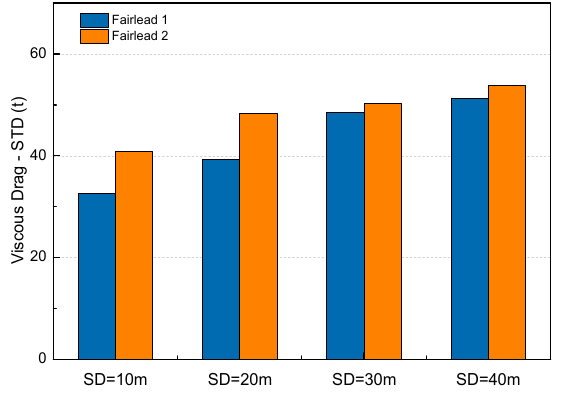
Figure 11. Statistical comparison of viscous drag force.